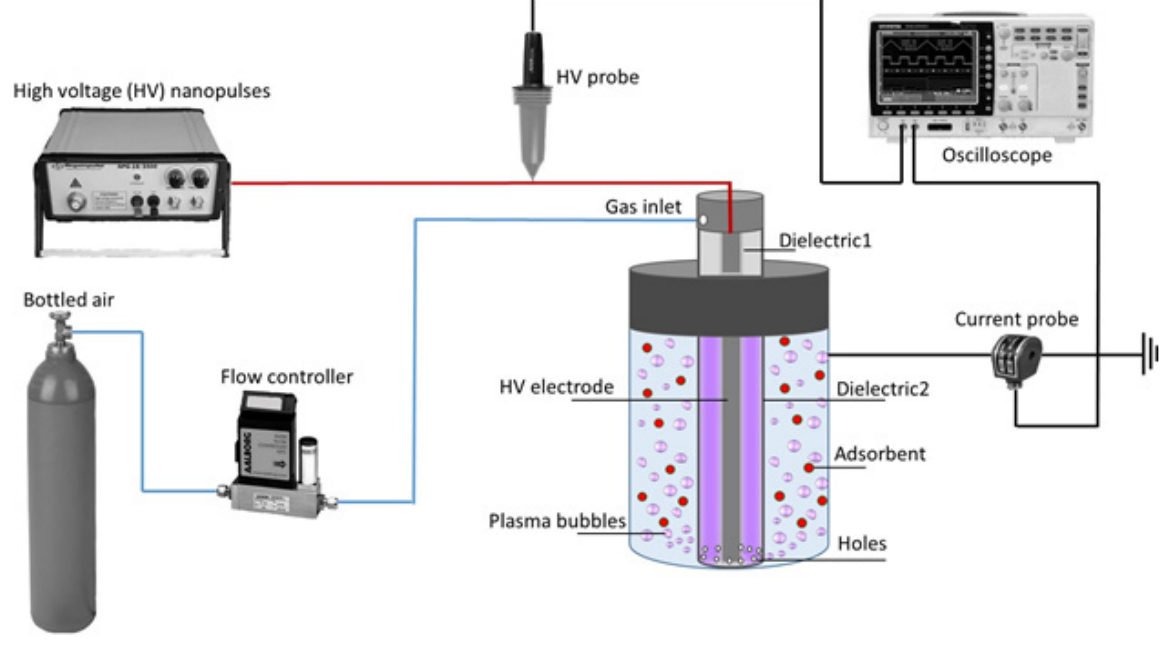
Figure 1. Schematic representation of the experimental setup used to regenerate HNC adsorbent by cold atmospheric plasma (CAP) bubbling.